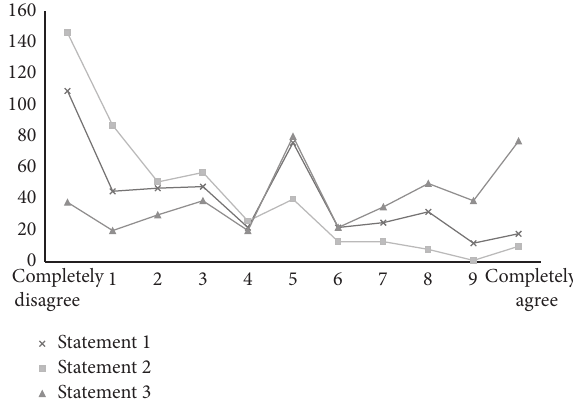
Figure 1: Survey II respondents rating of three statements con- cerning Macintosh, videolaryngoscopy and fibreoptic laryngoscopy. Learningtousesupraglotticdevicesismoreimportantthanlearning intubation with Macintosh laryngoscope: Statement 1. Learning to use videolaryngoscope is more important than learning intuba- tion with Macintosh laryngoscope: Statement 2. Learning to use fibrescope in awake patients is more important than learning to use videolaryngoscope: Statement